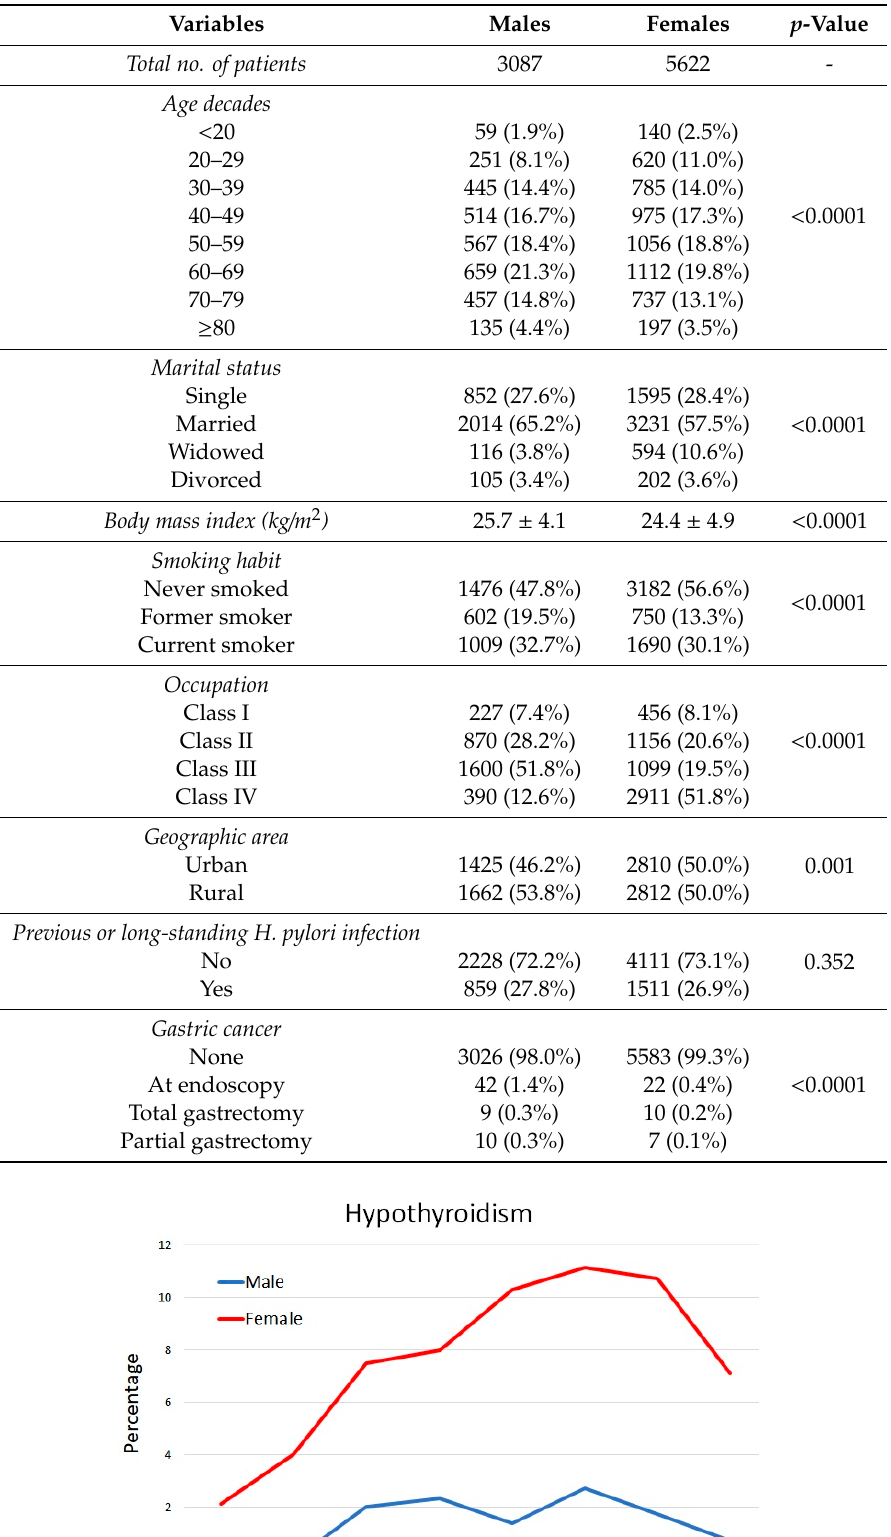
Table 1. Characteristics of the 8709 study participants.